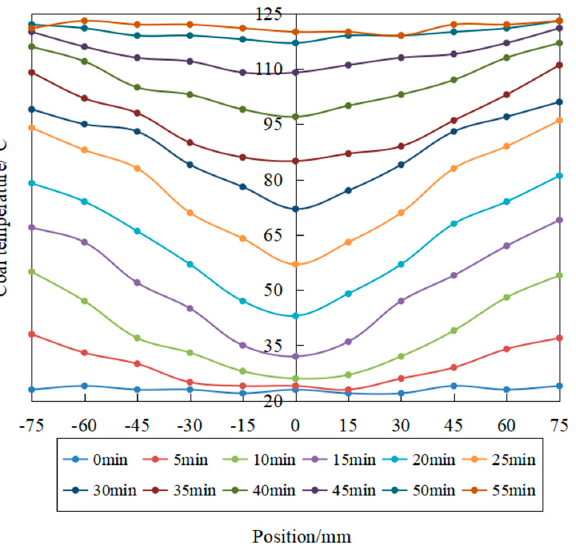
Figure 6. Characteristics of temperature distribution during the drying process.